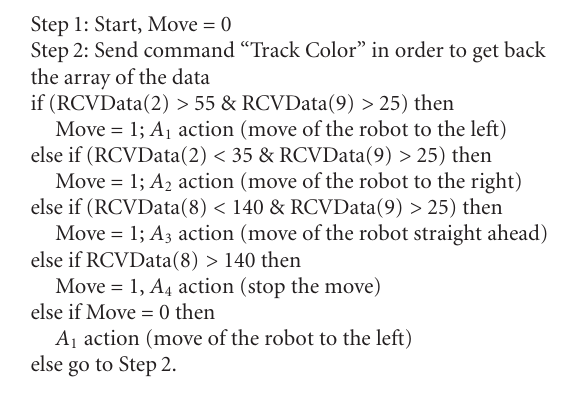
Pseudocode 1: Pseudocod of action